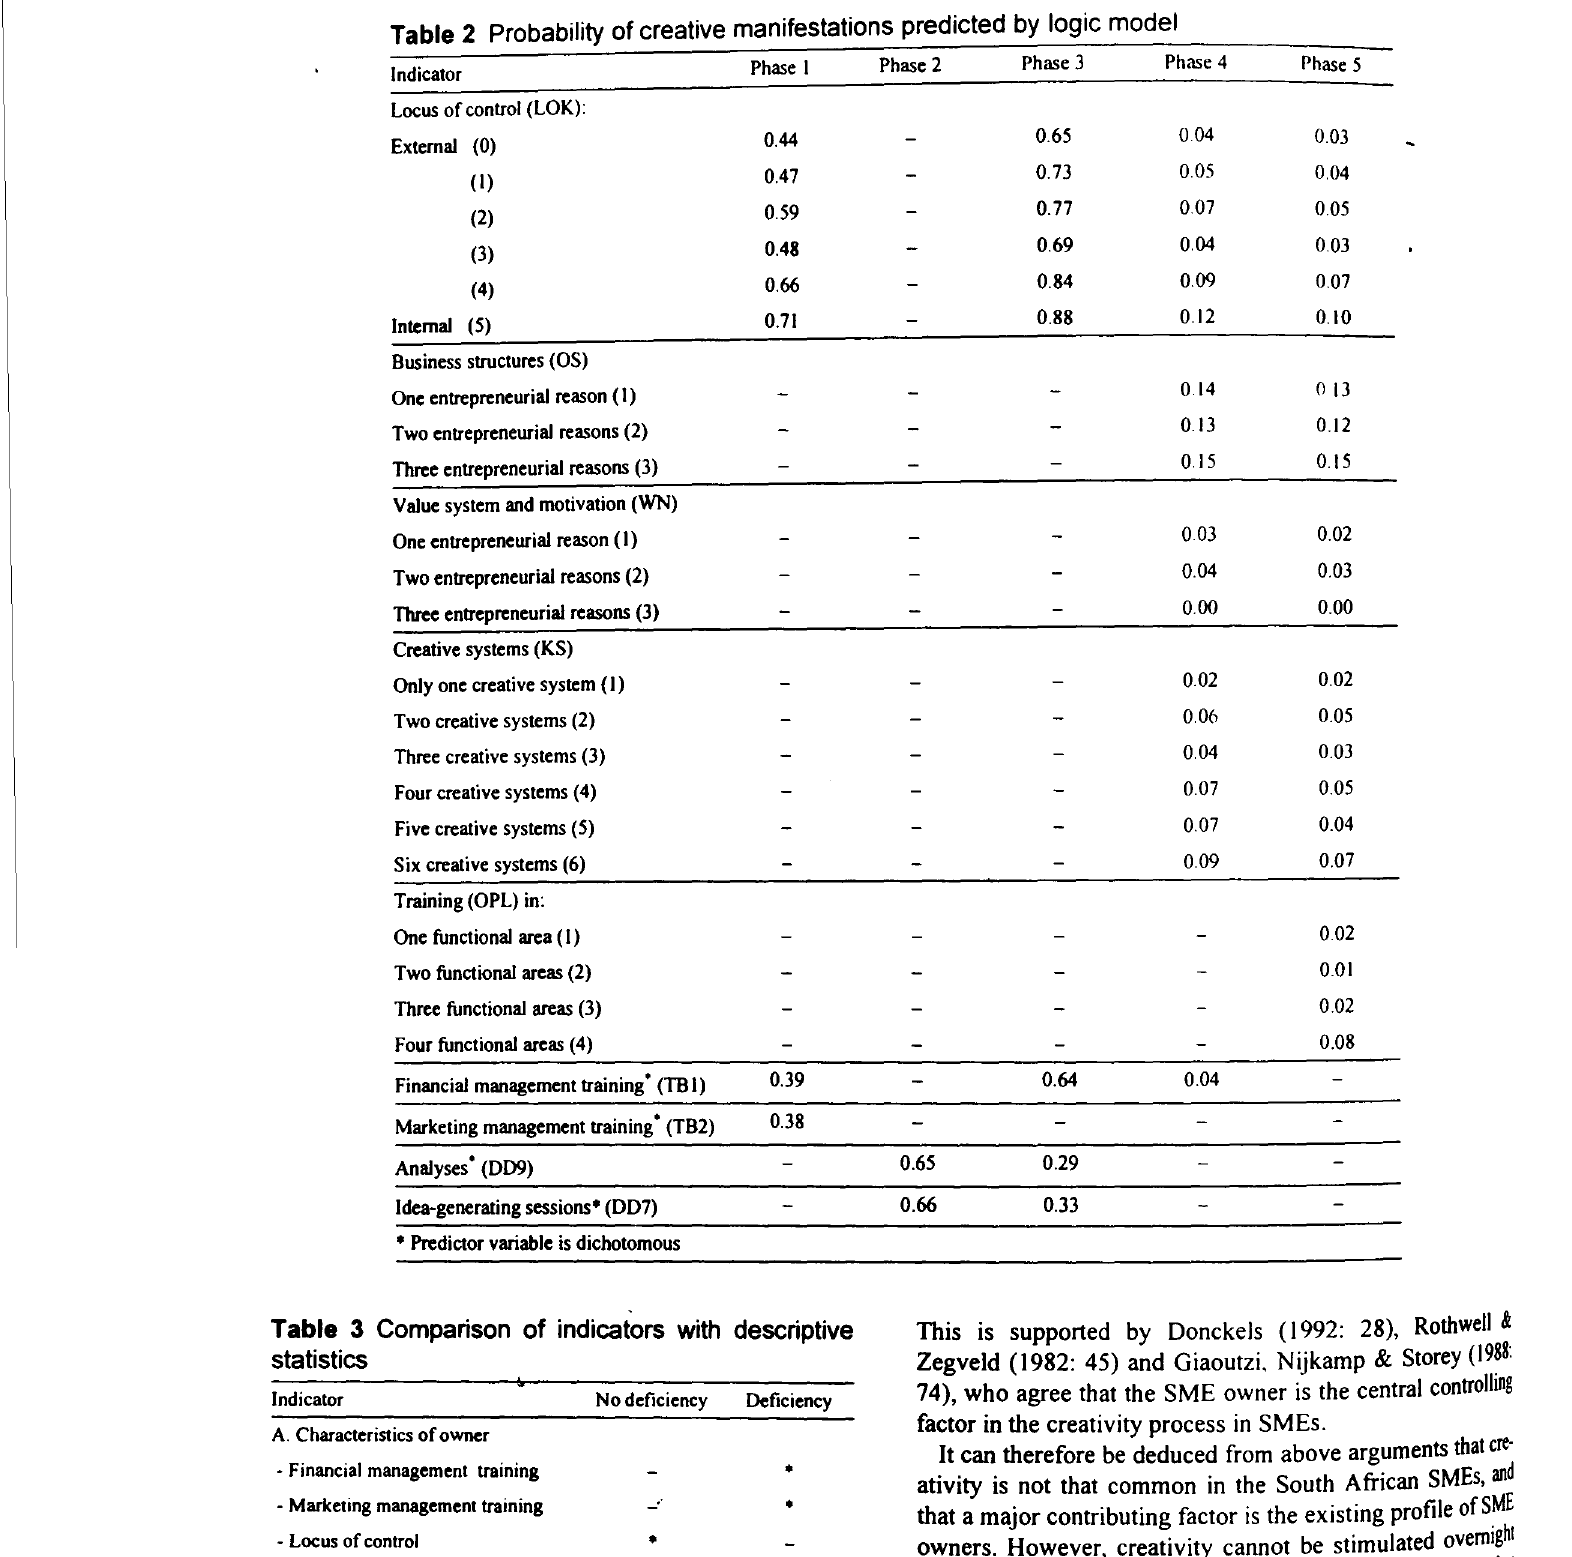
Table 2 Probability of creative manifestations predicted by logic model